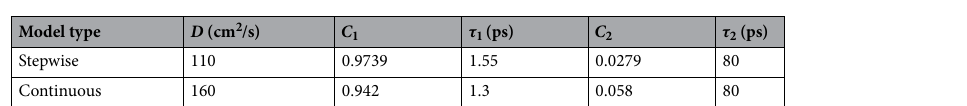
Figure 6. Theoretical predictions based on the SDM show excellent agreement with the experimentally measured PPTR traces for GaAs photocathode samples fabricated with ( a ) MOCVD and ( b ) MBE. Inset: The doping structure of the tested photocathodes.